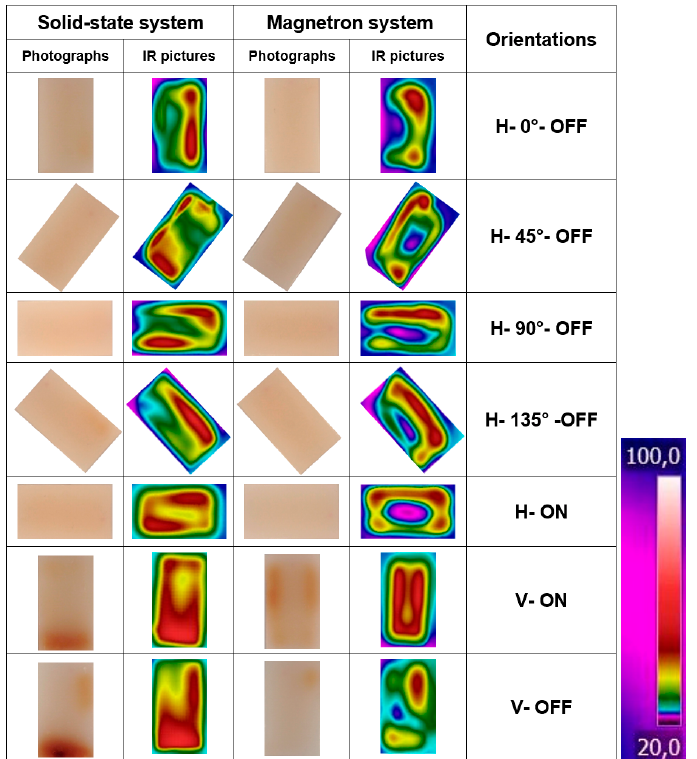
Figure 8. Thermal (IR) pictures and photographs of the A1 surface from gellan gel samples processed in the solid-state or magnetron microwave in different orientations. The temperature-color guideline is at right.